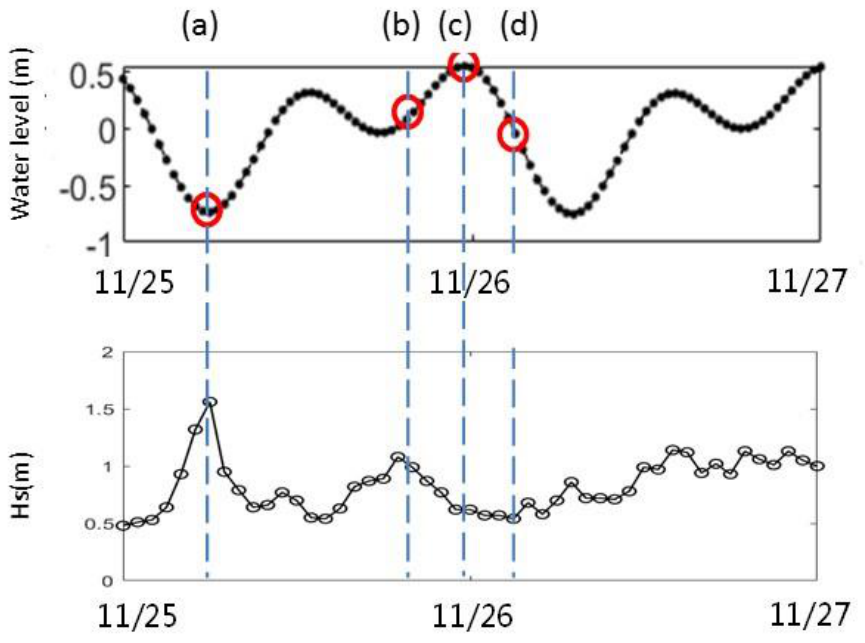
Figure 7. The simulated water level and significant wave heights at station A during different tidal hours: ( a ) the maximum ebb with energetic waves, ( b ) flood tides with moderate waves, ( c ) the maximum flood tide with mild waves, and ( d ) ebb tide with mild waves.